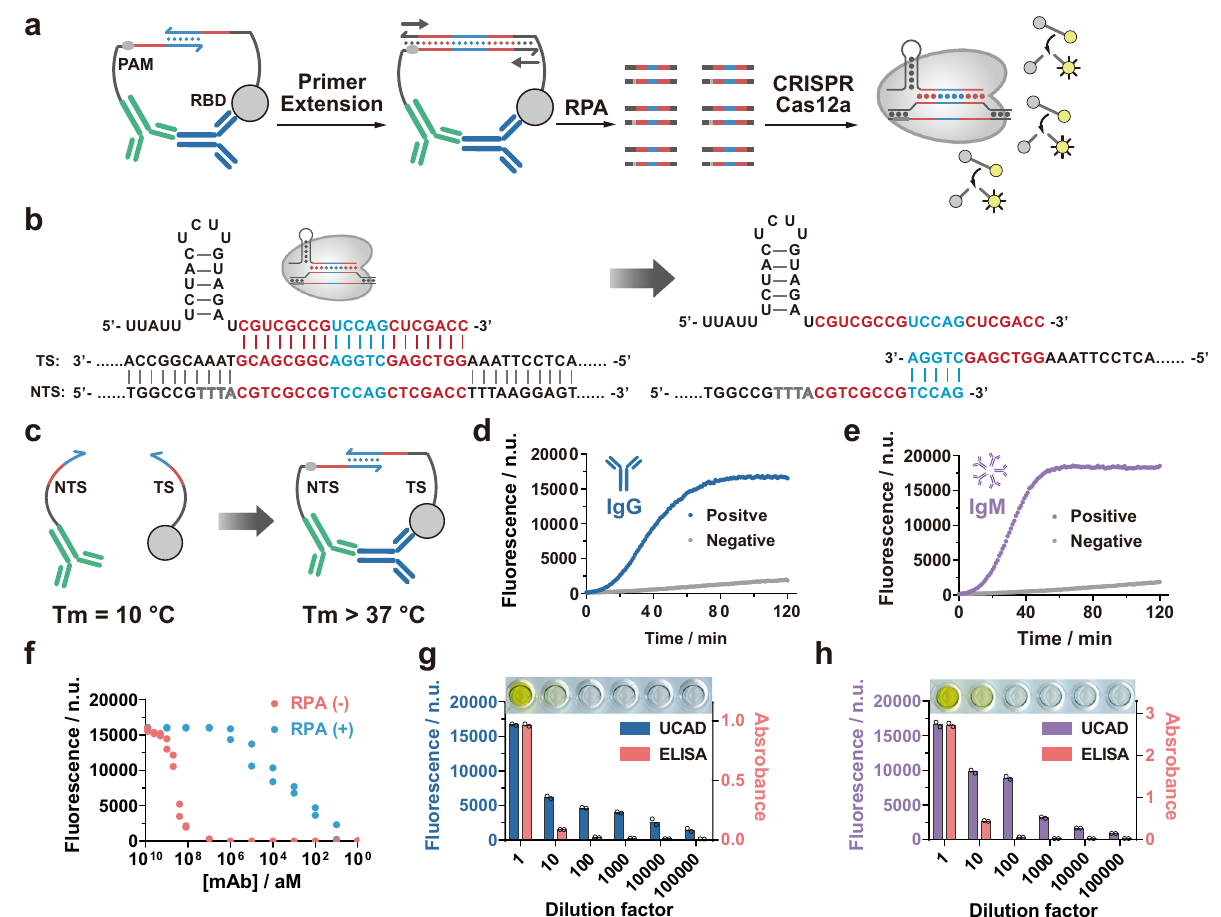
Fig. 1 | Design principle and sensitivity of UCAD. a Schematic illustration of the work fl ow of the UCAD assay. b Sequence design of the dsDNA template for trig- gering the collateral cleavage activity of CRISPR-Cas12a, as well as the strategy to splitthedsDNAtemplateintoTSandNTSprobesforUCAD. c Proximitybindingof the two UCAD probes to the same anti-RBD antibody through af fi nity motifs enhancestheT m oftheduplexdomainfrom10to46°Candthusenablesthestable binding between TS and NTS probes. d , e Kinetic curves for the detection of anti- RBD IgG ( d ) and IgM ( e ) in commercially purchased certi fi ed anti-SARS-CoV-2 IgG/ IgMpositive and negative serum samplesusing UCAD. f A calibration curve for the